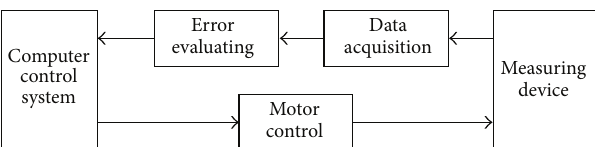
Figure 1: Structure of error measuring and evaluating.